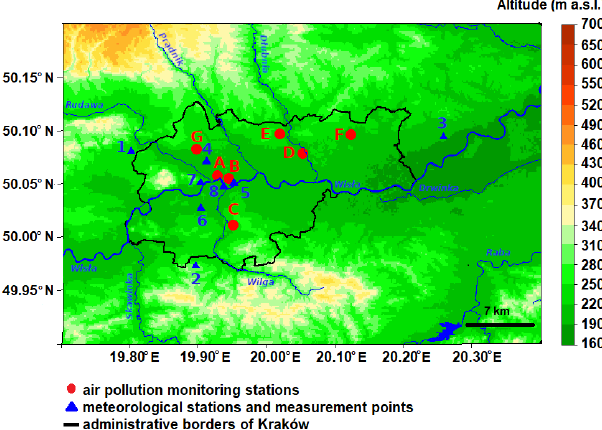
Figure 2. Location of the region studied at the junction of the Wisła River valley, Polish Uplands and Western Carpathian Foothills. Ex- planations: numbers and letters as in Tables 1 and